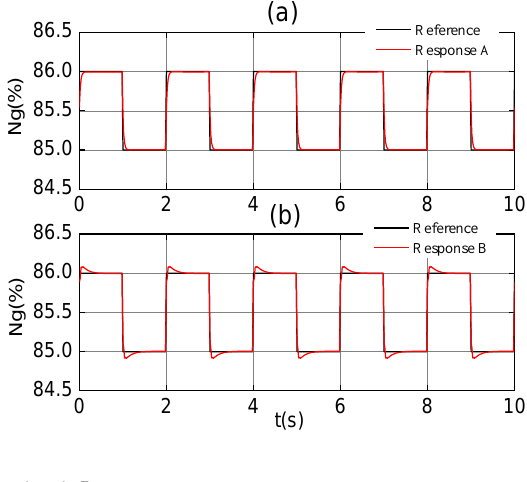
Figure 6. The response to step input by ( a ) PI controller with no delay; and ( b ) PID controller with